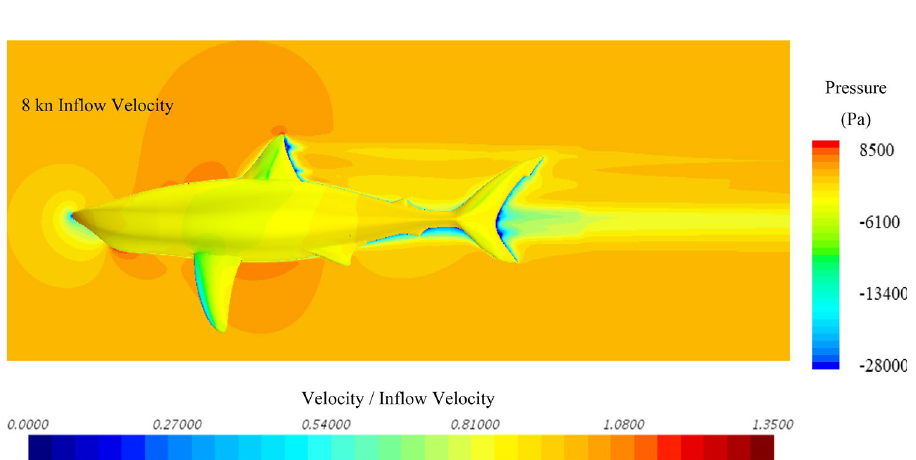
Figure 9. Velocity and pressure contours of the shark in free-swimming condition (Pressure contour displayed on the surface of model, and velocity contours displayed on the section plane) (Created using Simcenter STAR- CCM + 2019.2.1 Build